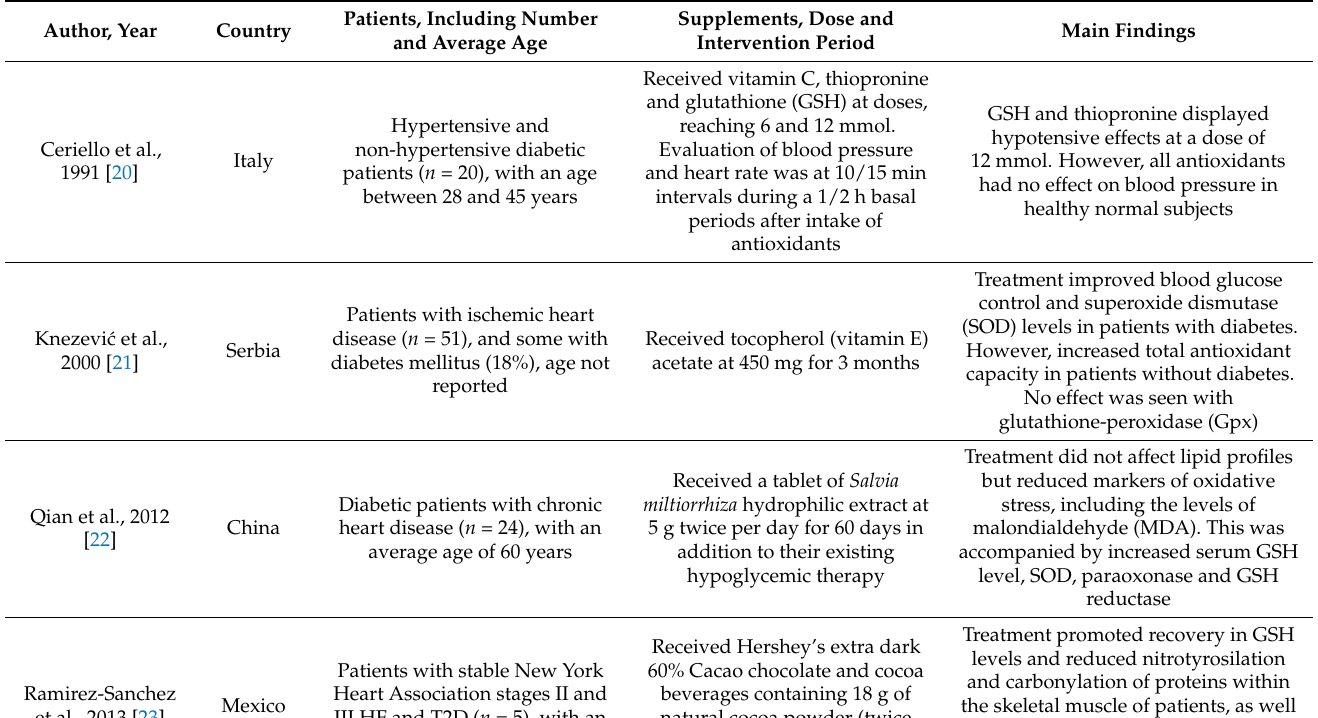
Table 1. Evidence on the effects of dietary supplements on plasma glutathione (GSH) levels and cardiometabolic